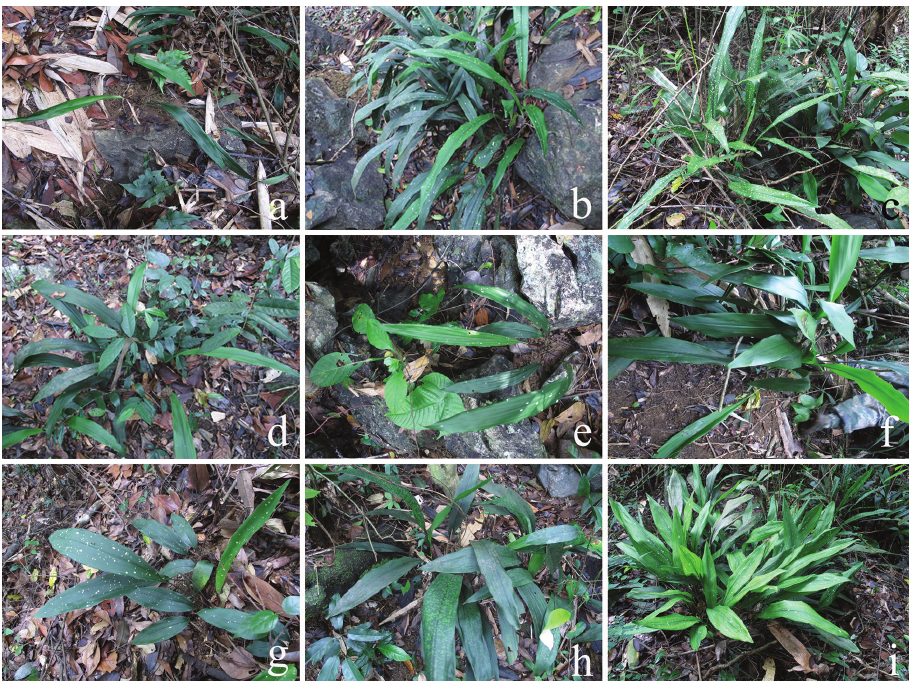
Figure 6. Leaf morphology of tetraploid plants of Aspidistra subrotata. from 4th boundary marker popu- lation. a–c sublinear leaves with a. smooth face b blotches c blotches and raised secondary veins d–e nar- rowly lanceolate leaves with d smooth face e blotches f–h ovate–lanceolate leaves with f smooth face g blotches h blotches and raised secondary veins i plants with ovate–lanceolate leaves and ones with sublinear leaves grow